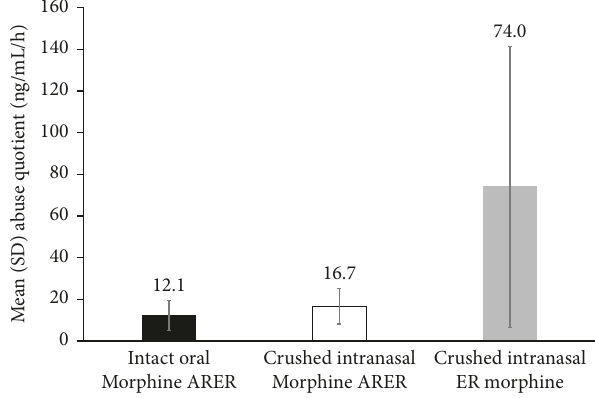
Figure 2: Mean (SD) abuse quotient. SD